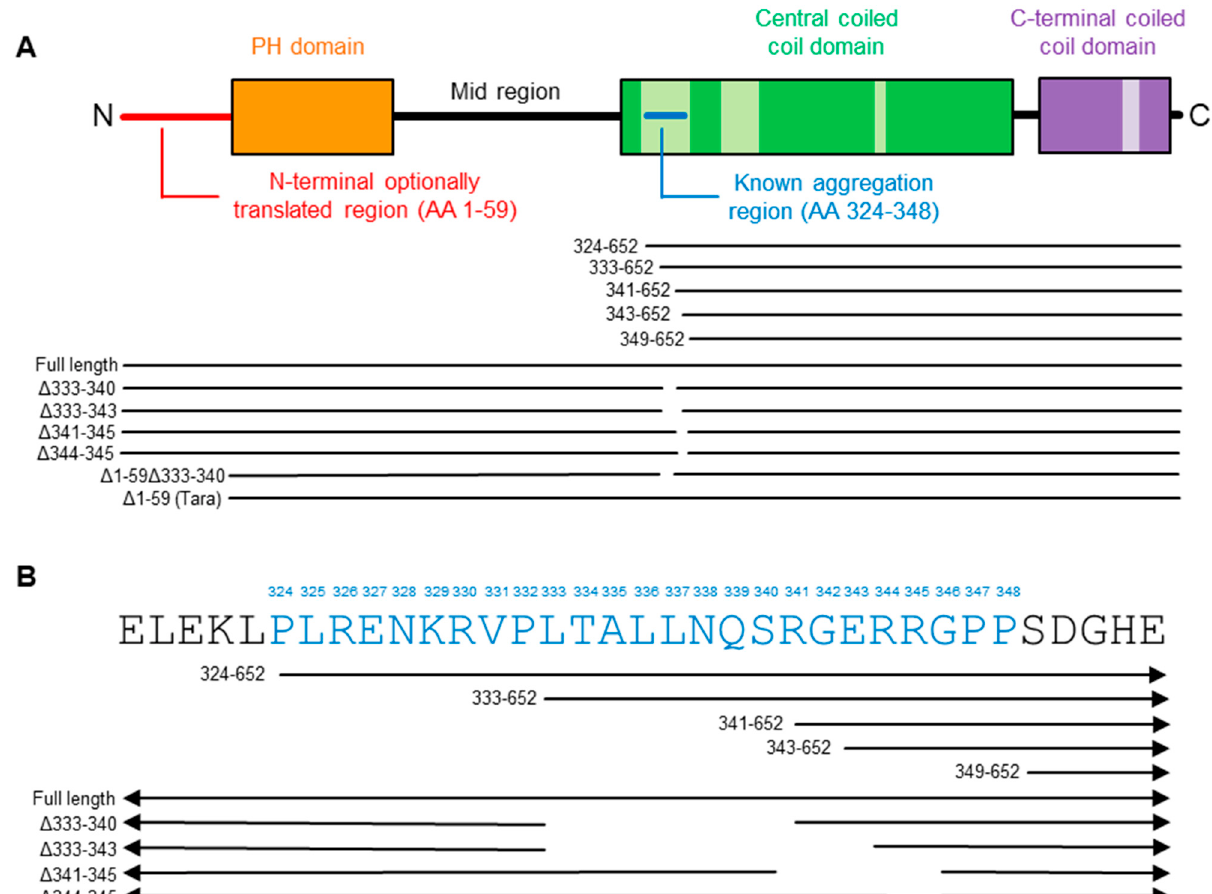
Figure 1. The known domain structure and aggregation critical region of TRIOBP-1 (Trio and F-actin Binding Protein isoform 1) ( A ) The domain structure of TRIOBP-1, shown in a one-dimensional format, as determined previously [11,14,15,23]. In coiled-coil domains, predicted coils are shown in darker shades, while loops are shown in paler shades. Amino acid (AA) numbers refer to the 652 AA form of TRIOBP-1, which includes the optionally translated region. ( B ) A section of the primary structure of TRIOBP-1, with the amino acids previously implicated in protein aggregation [15] shown in blue. Below each image are shown the regions of this protein contained in each of the major TRIOBP-1 plasmids used in this paper. More details of these plasmids can be found in Supplementary Table S1.